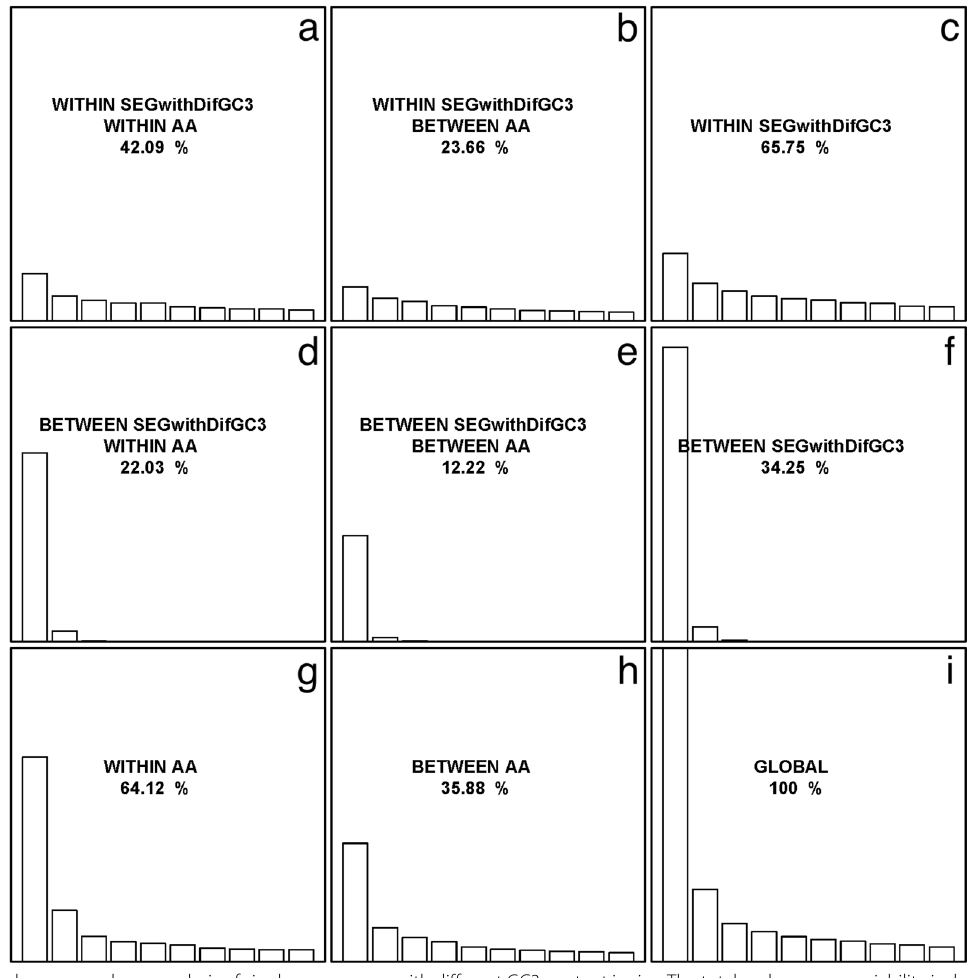
Fig. 7 Internal correspondence analysis of single-exon genes with different GC3 content in rice. The total codon usage variability is decomposed into the synonymous codon usage variability ( a , d , g ), amino acid usage variability ( b , e , h ), and variability of within ( a , b , c ) and between different GC3 content groups ( d , e , f ). The performance of ICA yields nine elementary analyses ( a–i ). In each peculiar analysis, the contribution to the total codon usage variability is indicated, where only the first 10 eigenvalues are represented for